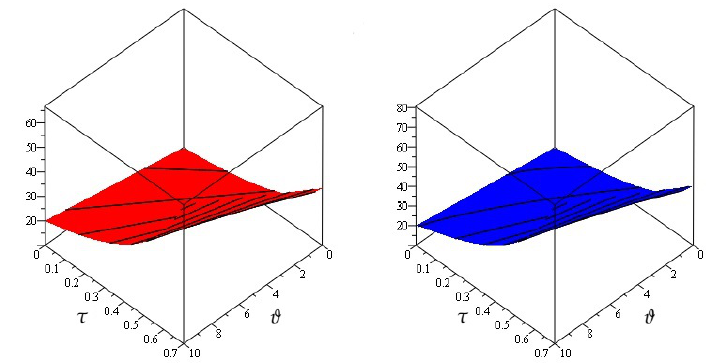
Figure 1. Exact and analytical solution of ν ( ϑ , ζ , τ ) at (cid:36) = 1 and 0.8 of Example 1.